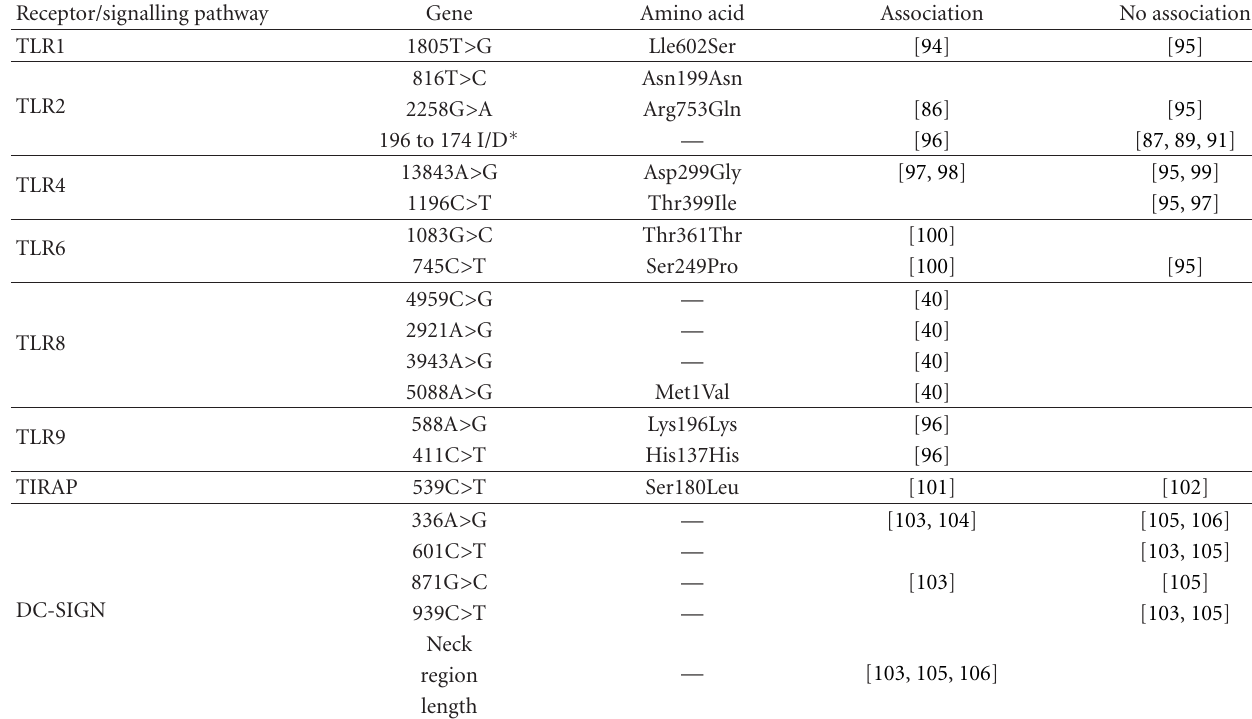
Table 1: SNPs associated with susceptibility to